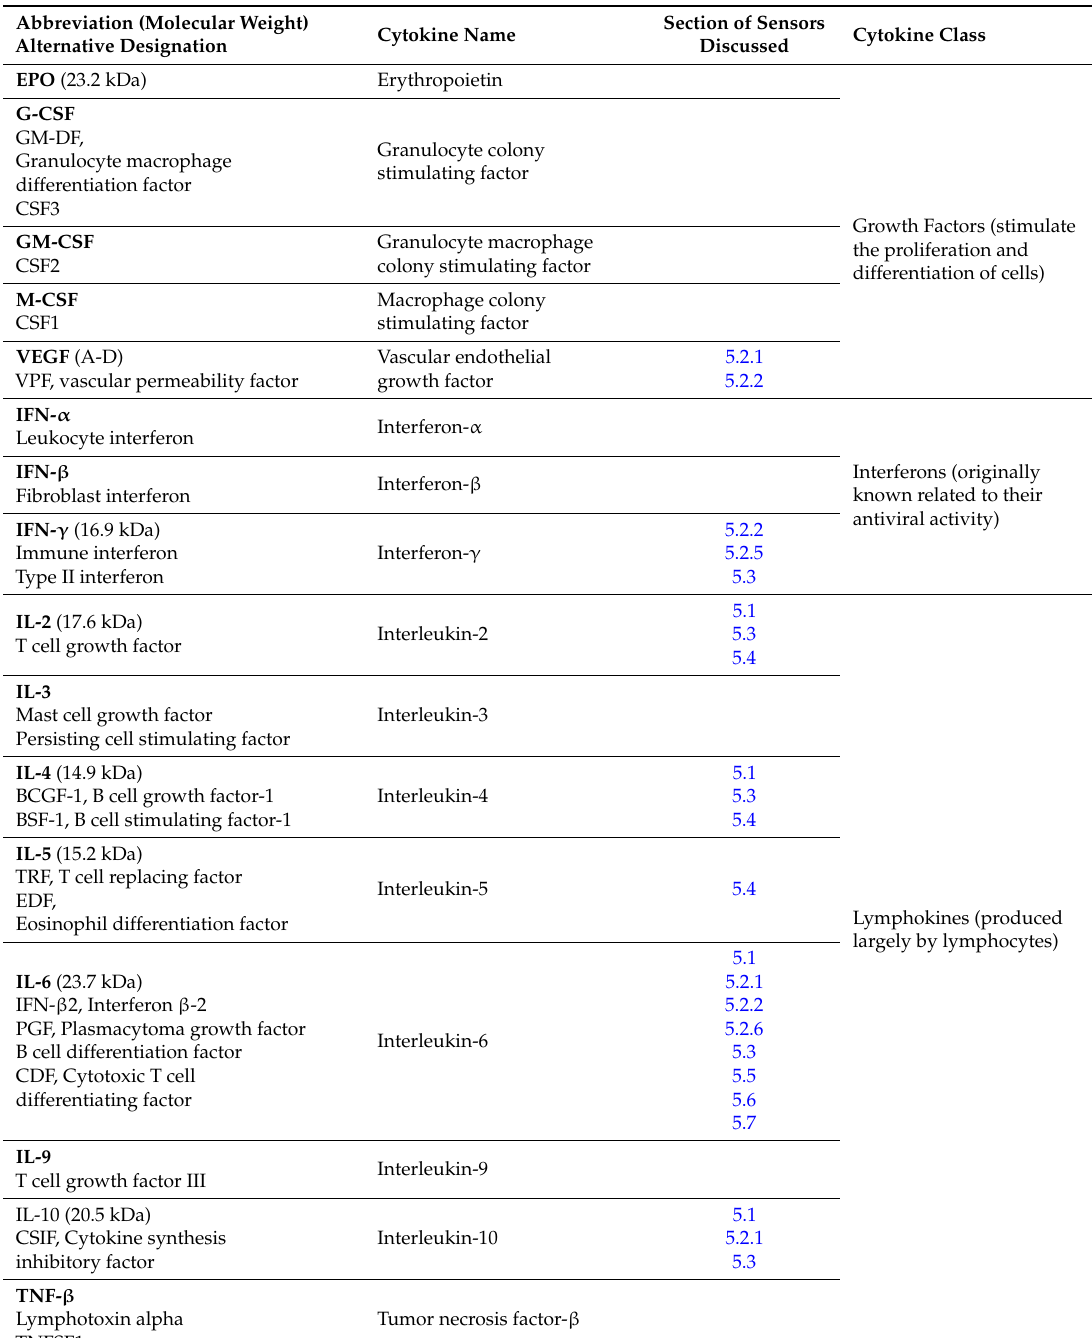
Table 1. Various cytokines and their commonly used abbreviations. Each cytokine is listed along with its alternative name and the relevant section in the